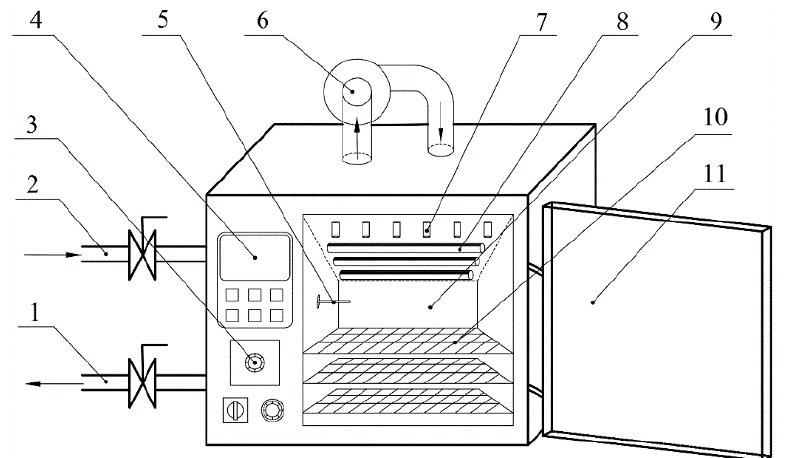
Figure 1. Schematic of the short- and medium-wave infra-red dryer. 1. wet discharging port, 2. air inlet port, 3. wind speed adjusting knob, 4. touch screen, 5. temperature sensor, 6. centrifugal fan, 7. spray nozzle 8. quartz infrared heating tube, 9. drying chamber, 10. material tray, 11. door.